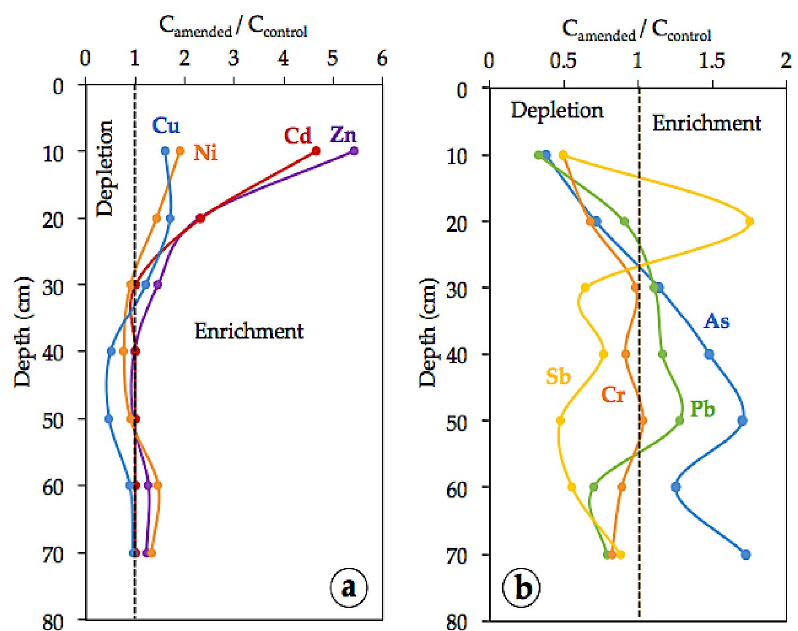
Figure 5. Soil profile distribution of the concentration factor (calculated by dividing the total content of each trace element in the amended soil by that in the unamended soil) for: ( a ) Cd, Cu, Ni, and Zn; and ( b ) As, Cr, Sb, and Pb.